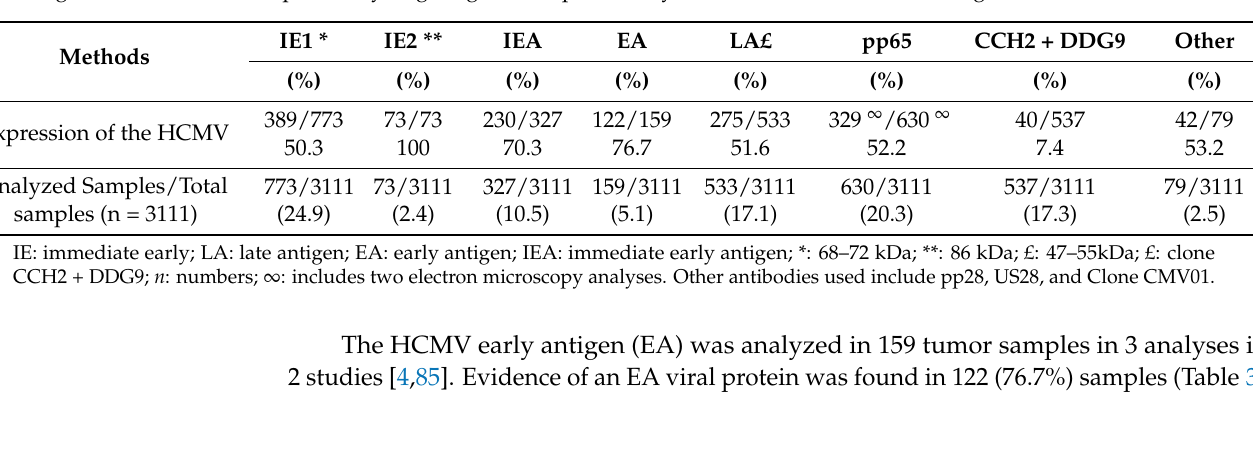
Table 3. Summarized results from published studies showing expression of the HCMV proteins in GBM tissue specimens using different antibodies specifically targeting HCMV-proteins by immunohistochemical staining.